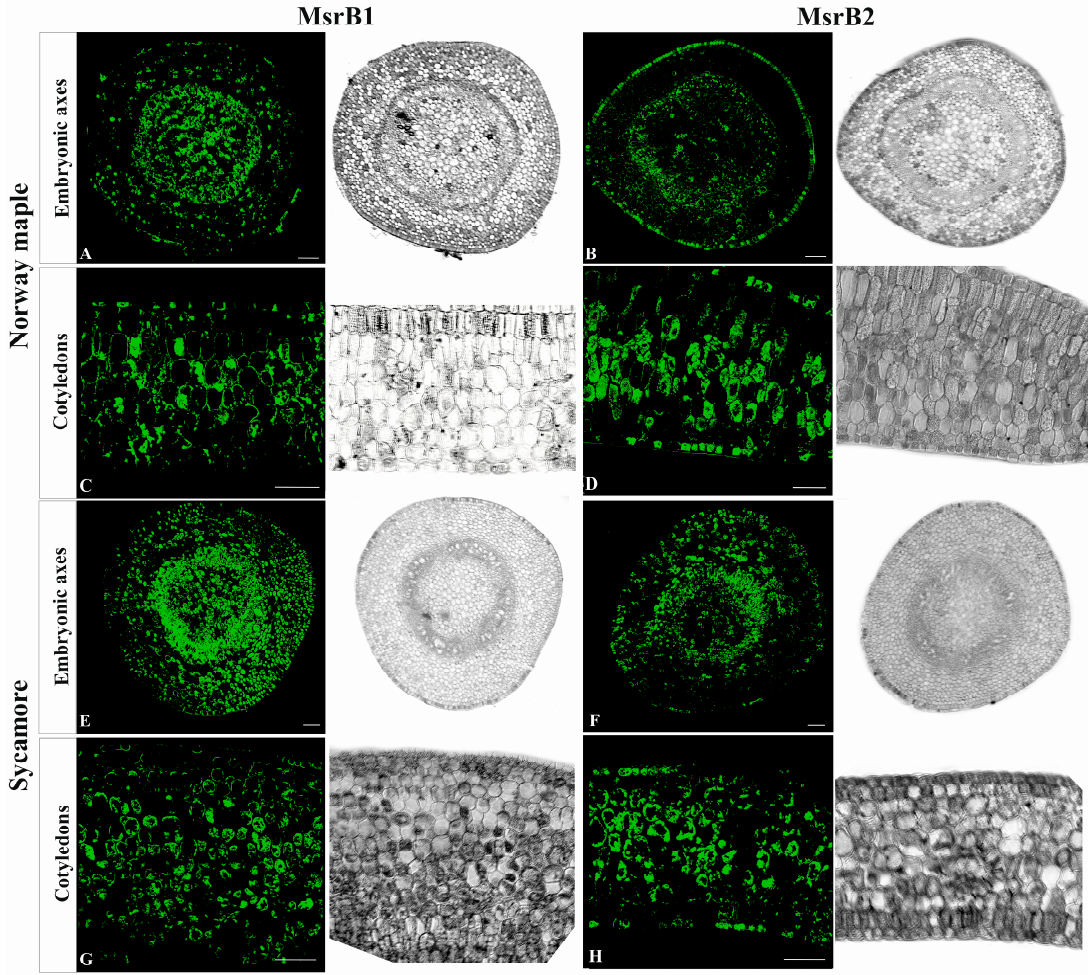
Figure 4. Immunohistochemical localization (green fluorescence) of MsrB1 and MsrB2 proteins in the embryonic axes ( A , B ) and cotyledons ( C , D ) of mature Norway maple seeds and in the embryonic axes ( E , F ) and cotyledons ( G , H ) of mature sycamore seeds. Bars = 100 µm. Two negative controls were performed: (1) omitting the primary antibody and (2) omitting antibodies conjugated with HRP. Reactions carried out on embryonic axes and cotyledons of both species confirmed specificity of primary antibodies (Figure 5).